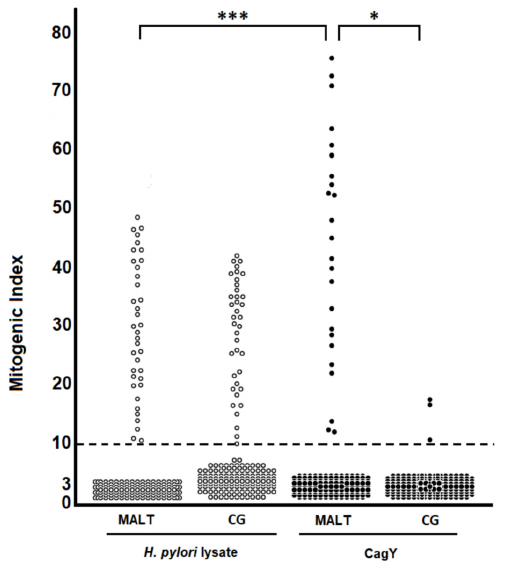
Figure 1. Antigen specificity of H. pylori -reactive T cell clones derived from the gastric mucosa of H. pylori -infected patients with low-grade MALT B cell lymphoma (MALT) or uncomplicated chronic gastritis (CG). In vivo activated T cells were recovered from biopsy specimens of gastric mucosa and cloned by limiting dilution. T cell blasts from each clone were seeded in triplicate cultures with irradiated autologous peripheral blood mononuclear cells in the presence of medium alone or optimal doses of H. pylori lysate (10 μ g/mL), or CagY (1 μ g/mL). After 60 h, [ 3 H] thymidine uptake was measured and expressed as mitogenic index. A significant difference (*) was found between the mitogenic index of CagY-specific MALT lymphoma-derived T clones and CG-derived ones. A highly significant (***) proliferation to CagY than to H.pylori lysate was found in MALT lymphoma-derived T clones.